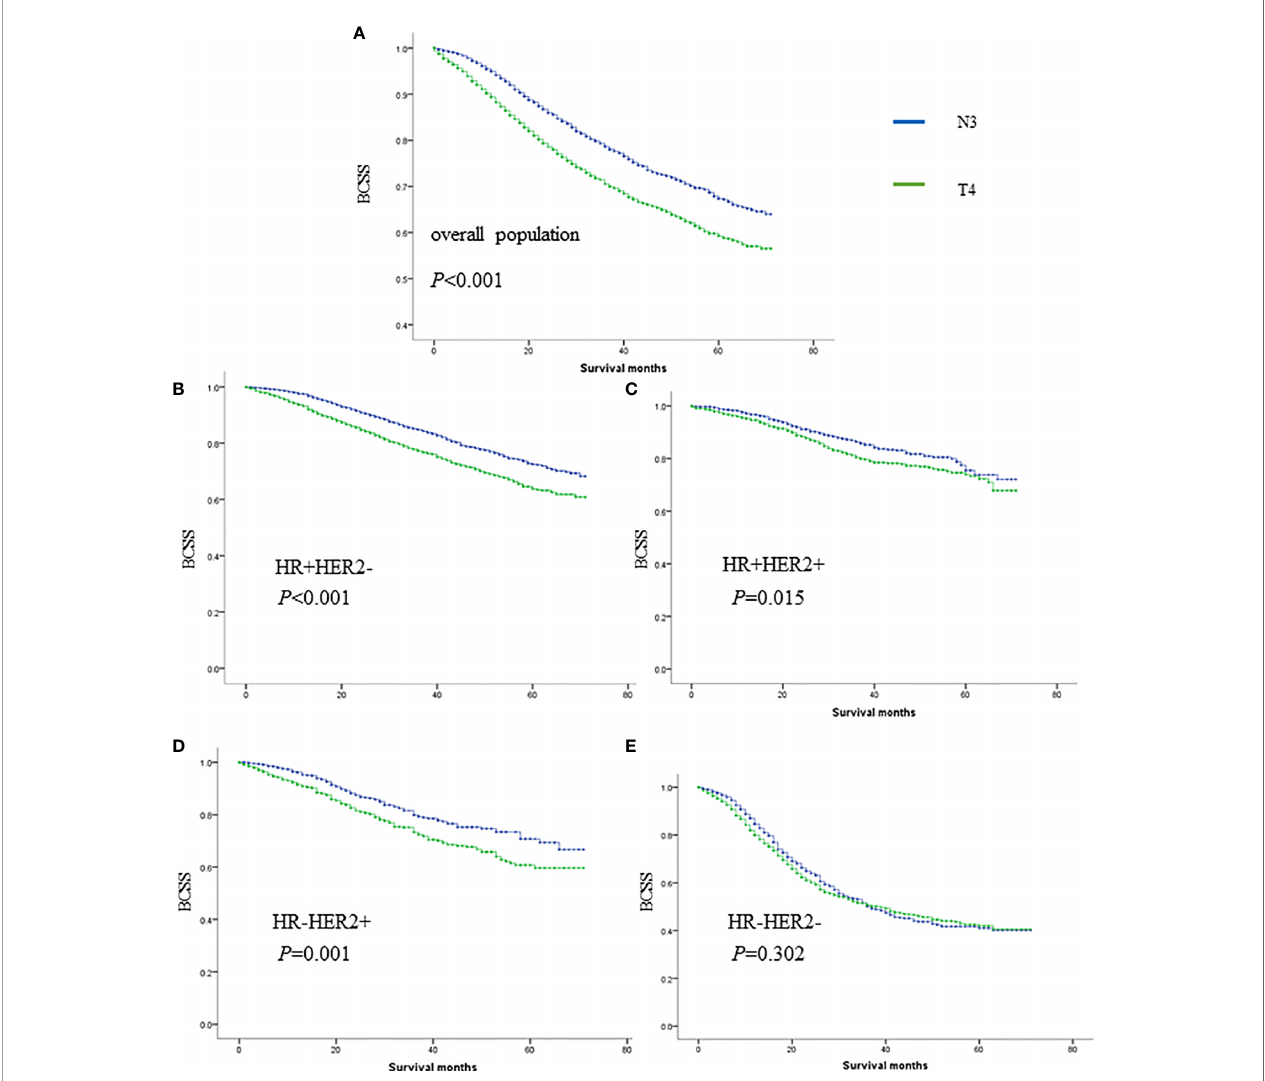
FIGURE 4 | The survival comparisons of T4 and N3 tumors in whole population (A) , HR+HER2- (B) , HR+HER2+ (C) , HR-HER2+ (D) and HR-HER2- (E)